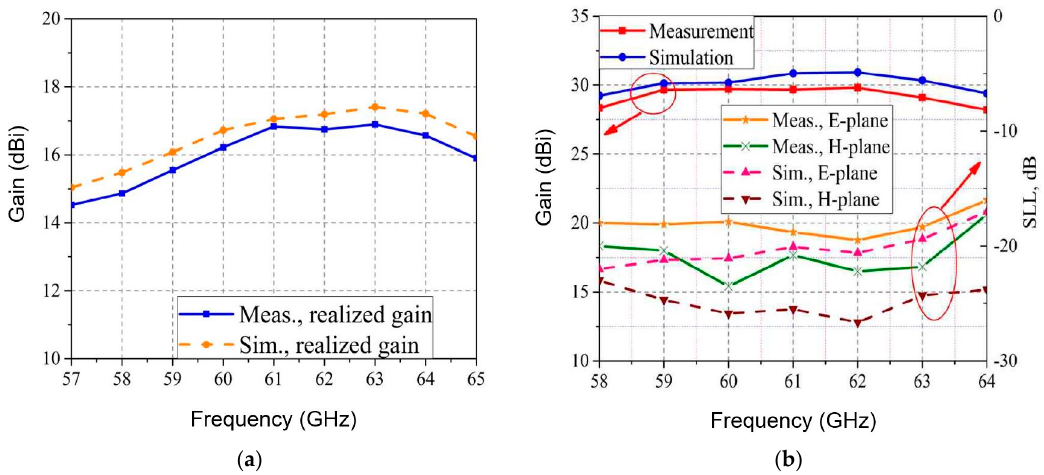
Figure 39. V-band antenna array measurement: ( a ) gain of the feed antenna; ( b ) gain of antenna array.